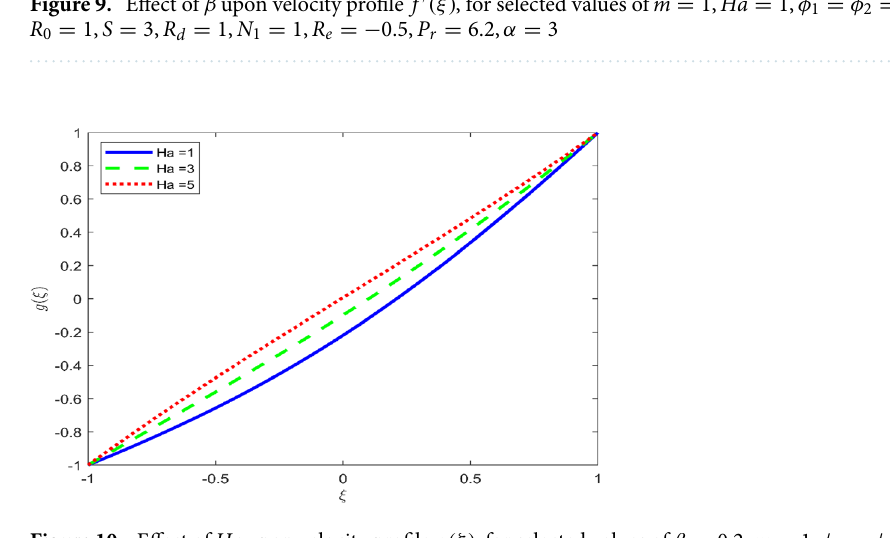
Figure 10. Effect of Ha upon velocity profile g (ξ) , for selected values of β 1, S 3, R 1, N 1 1, R R 0 e = − d = = = =